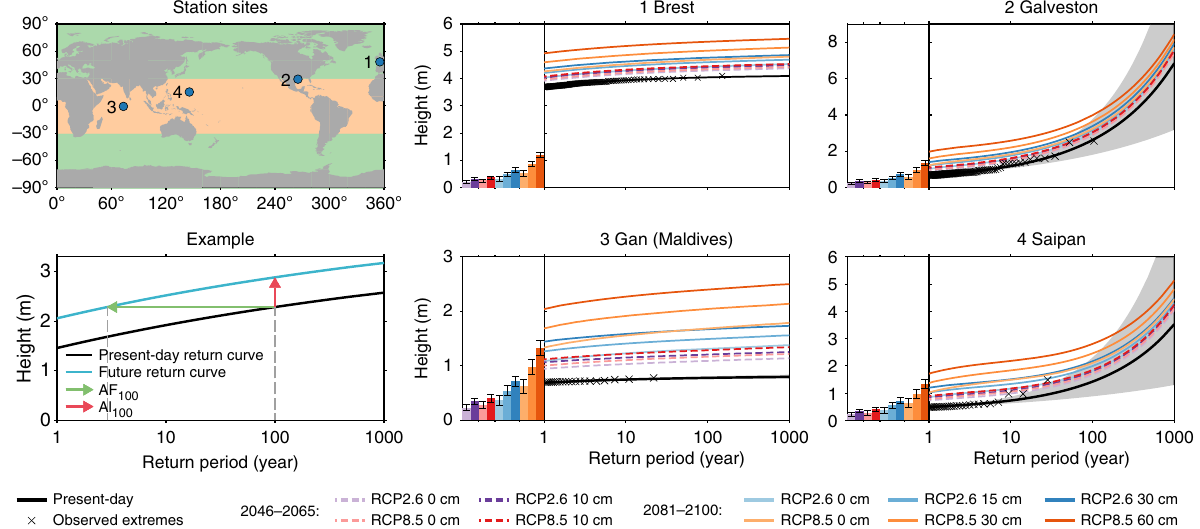
Fig. 2 Example return curves. a The station sites and the regions that correspond with the tropics (orange) and extratropics (green). d An example return curve and the de fi nition of the 100-year allowances (Al 100 ) and ampli fi cation factors (AF 100 ). The other panels show the present-day return curves and the curves after future MSL changes relative to 1986 – 2005 mean. The MSL changes are shown in the bar chart next to each panel. The numbers in the bar chart show the location (loc), scale (scl), and shape (shp) parameters of the return curve for the corresponding station. The shaded area shows the [5 − 95]% con fi dence interval of the present-day return curve, which is computed from the uncertainties in the estimated extreme-value distribution parameters, see methods for more details. The y -axis differs between sub-panels. Note that for Brest and Gan, the con fi dence interval is displayed, but small, compared to the scale of the